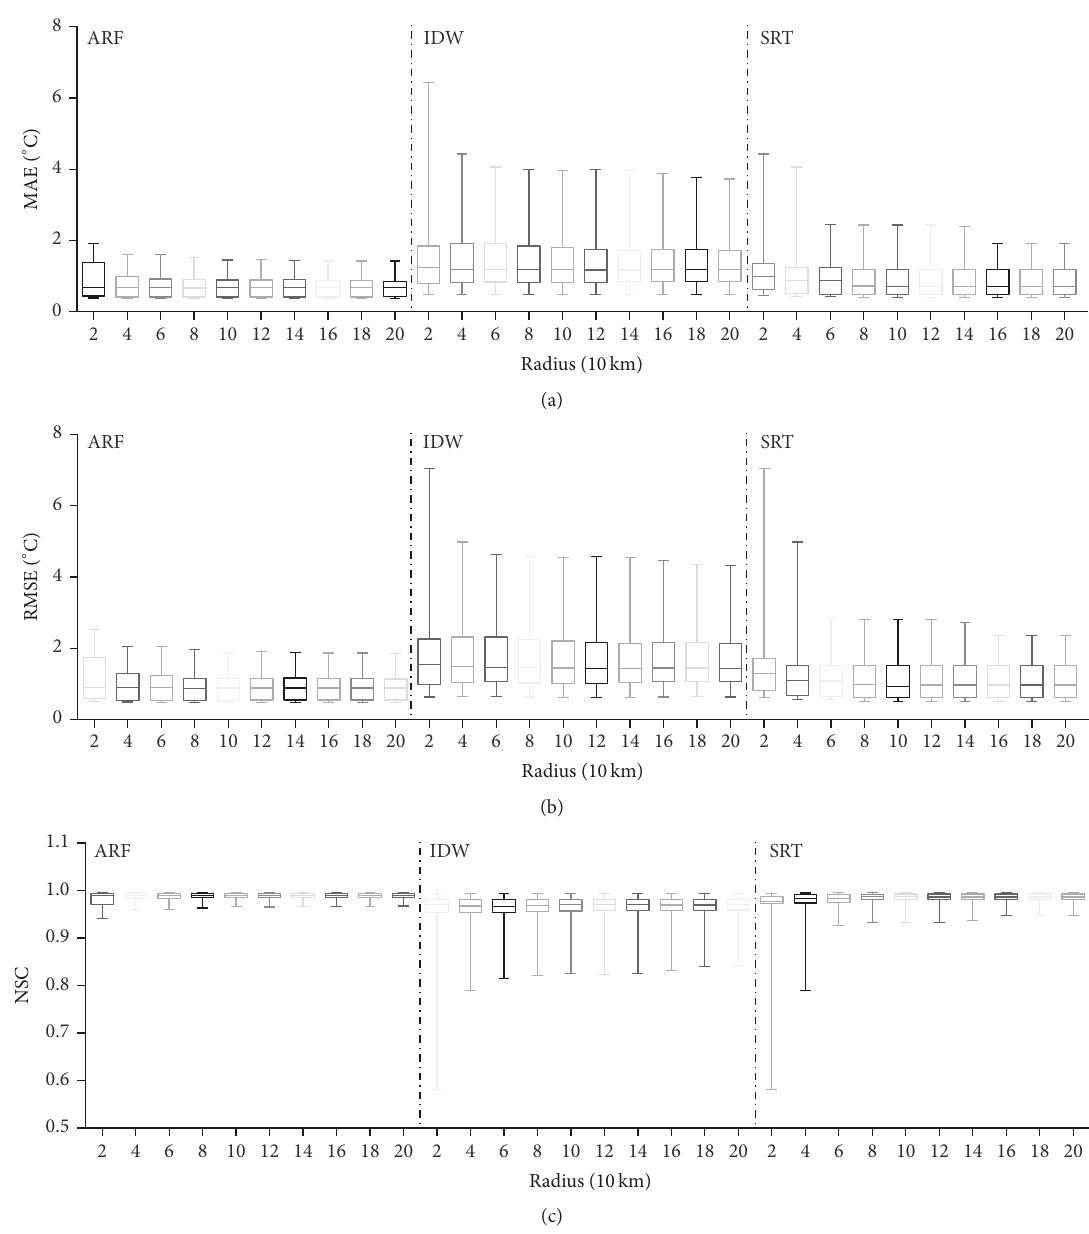
Figure 5: Performance indexes of different radii for six target stations at different times for the IDW, SRT, and ARF methods: (a) MAE, (b) RMSE, and (c)